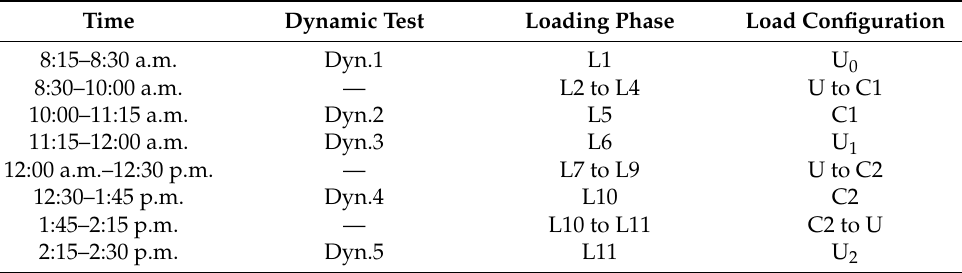
Table 2. Main AVTs that were performed during the loading